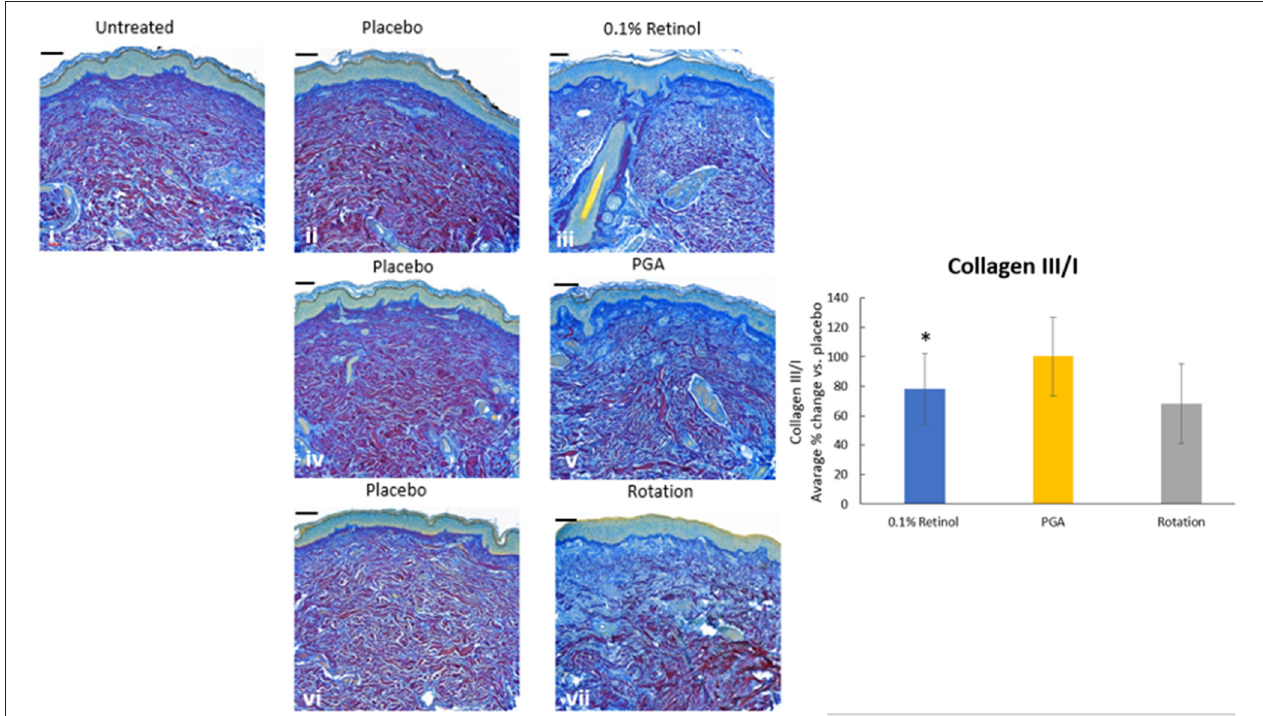
FIGURE 10 | Immunohistology of skin biopsies. Volunteers ( n = 32) received application of either 0.1% retinol formulation for 4 weeks or weekly rotation of 1% phytol/4% glycolic acid (PGA) formula with 0.1% retinol formula. Biopsy samples were taken at the end of the 4-week period. An analysis of Col III/I ratio in in vivo skin samples using Herovici staining was performed to differentiate mature collagen (type I) (pink/red) and immature collagen (type III) (blue). All treatments led to increase in collagen III and improved the ratio of collagen III/I. i: untreated, ii: placebo for retinol, iii: retinol, iv: placebo for PGA, v: PGA, vi: placebo for vii, and vii: rotation of iii and v. *Scale bar = 100 µ